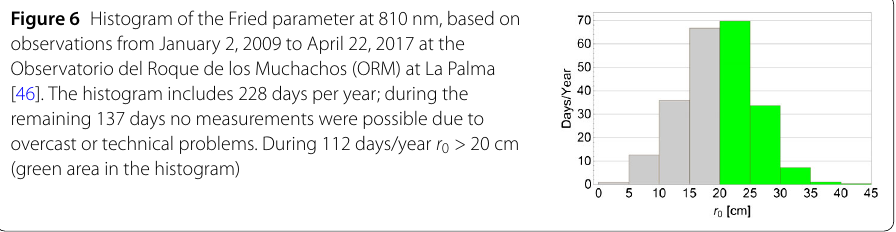
Figure 6 Histogram of the Fried parameter at 810 nm, based on observations from January 2, 2009 to April 22, 2017 at the Observatorio del Roque de los Muchachos (ORM) at La Palma [46]. The histogram includes 228 days per year; during the remaining 137 days no measurements were possible due to overcast or technical problems. During 112 days/year r 0 > 20 cm (green area in the